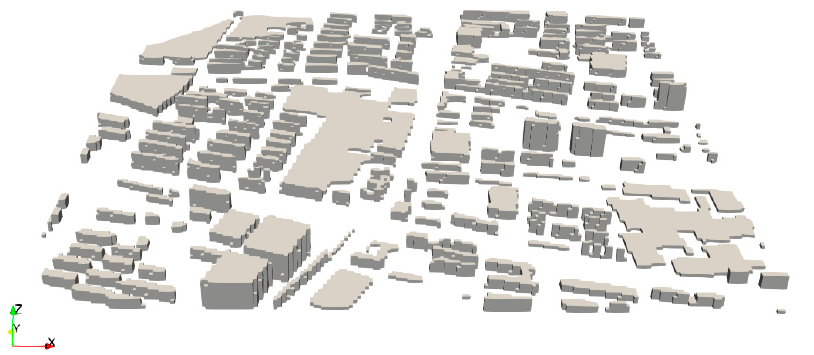
Figure 1. Three-dimensional view of the study area, a 1 km × 1 km × 200 m city block in the downtown area of Baoding, China. The grey cubes represent the shapes of the buildings within the study area.